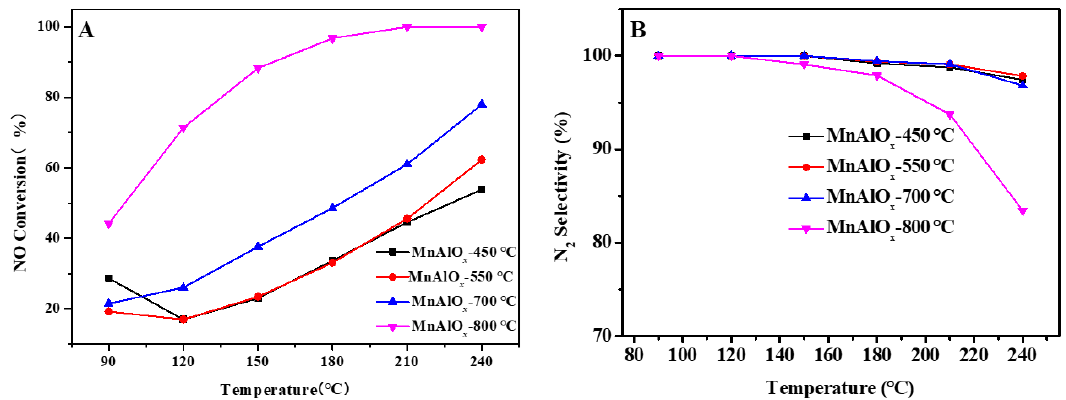
Figure 1. ( A ) The NO x conversion and ( B ) N 2 selectivity of MnAlO x catalysts.